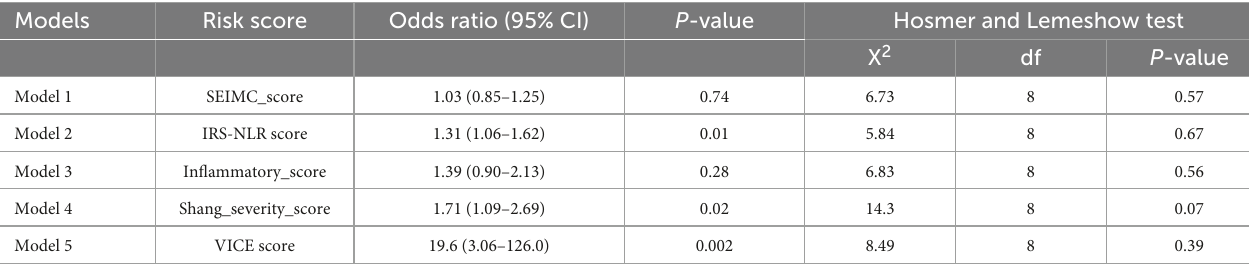
TABLE 4 Models of predictors of mortality. Models